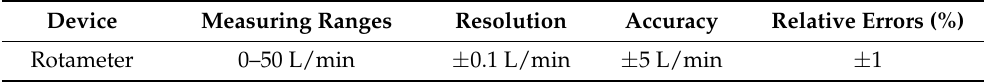
Table 3. Rotameter measurement